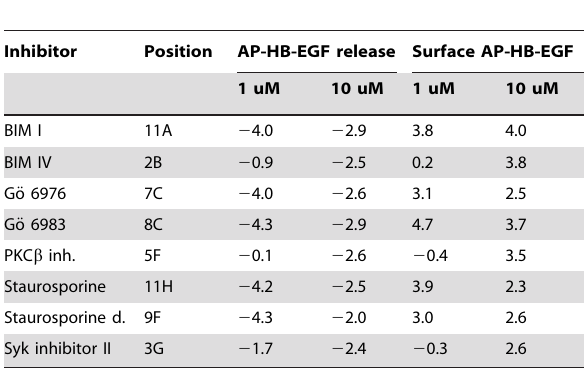
Table 1. Inhibitors with a z-score . 2 from InhibitorSelect TM Library I.